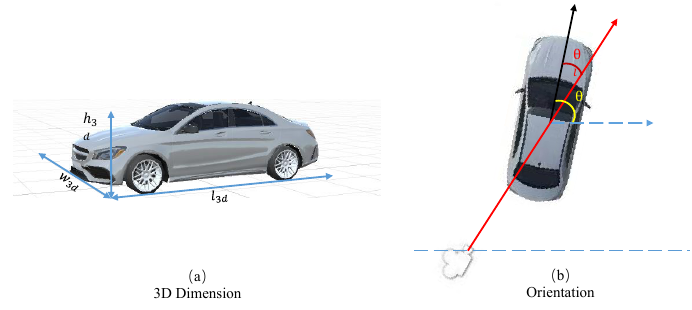
Figure 2. Illustration of the 3D dimension ( a ) and orientation ( b